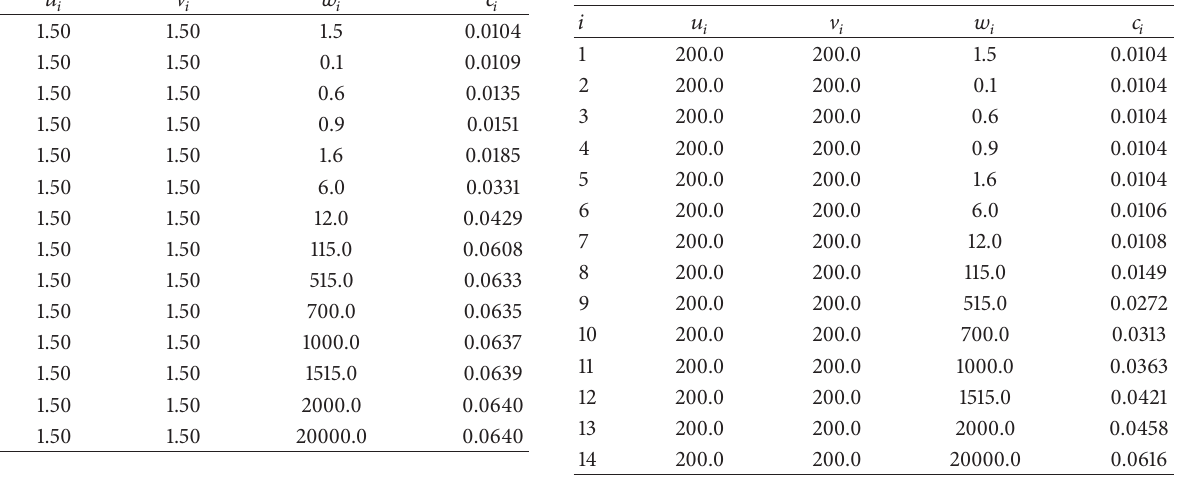
Table 10: Values of 𝑐 𝑖 for different values of shape parameters 𝑢 𝑖 , V 𝑖 , and 𝑤 𝑖 .